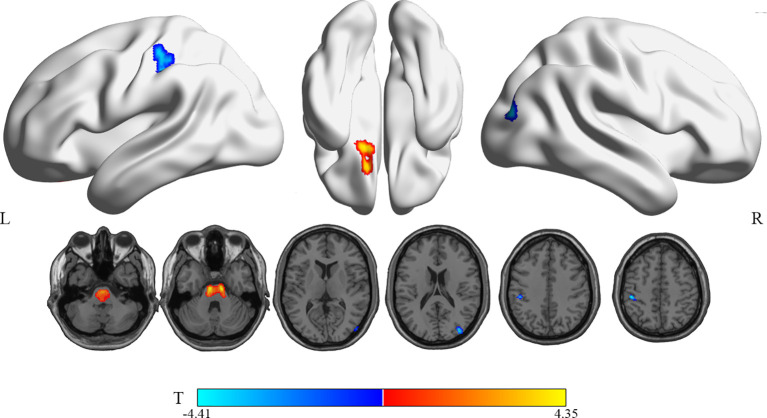
Brain regions with significant rCMRglu differences in WG compared with RG subjects. Compared with RG, glucose metabolism in WG patients decreased (cool) in the occipital_Mid_R and postcentral_L, but increased (warm) in the Frontal_Sup_Orb_L(uncorrected p-value <0.005; extend threshold = 150). The figure is depicted in neurologic orientation. The 3D render view and gray-scale image (a T1 structural MR image that is representative of MNI space). The color bar represents the T-value for each voxel.